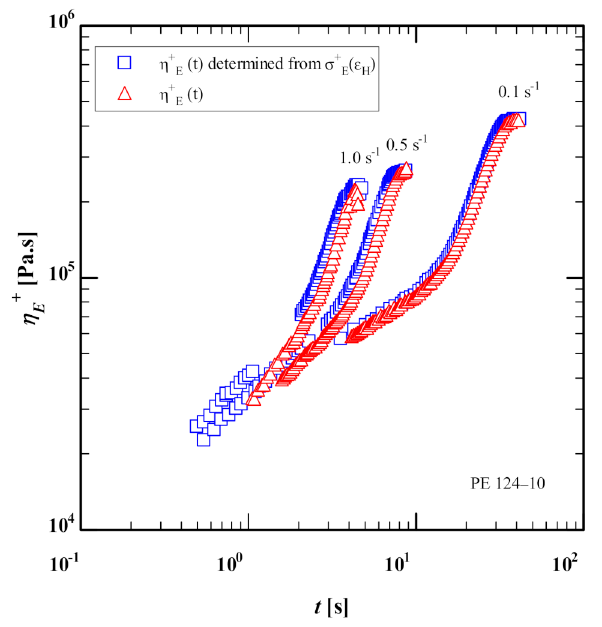
Figure 3. Comparison between extensional stress growth coefficient data as a function of time of PE 124-10 digitized from figure 3b (red triangle symbols) and figure 4 of [23] (blue square symbols) of Morelly and Alvarez